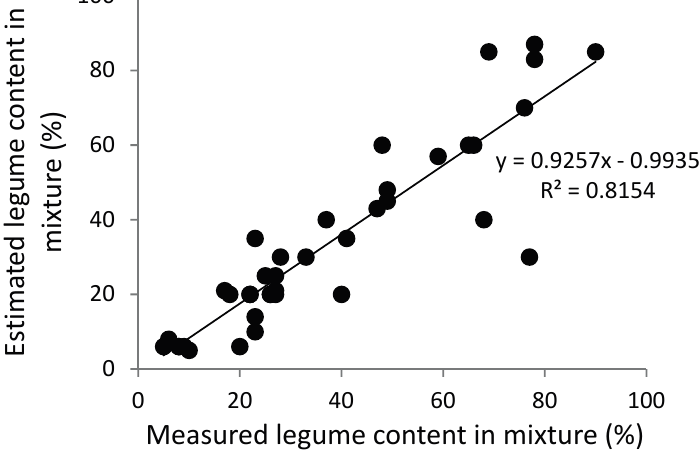
Figure 2. Correlation between measured and estimated legume content in legume-grass mixtures for users of the legume estimation trainer after